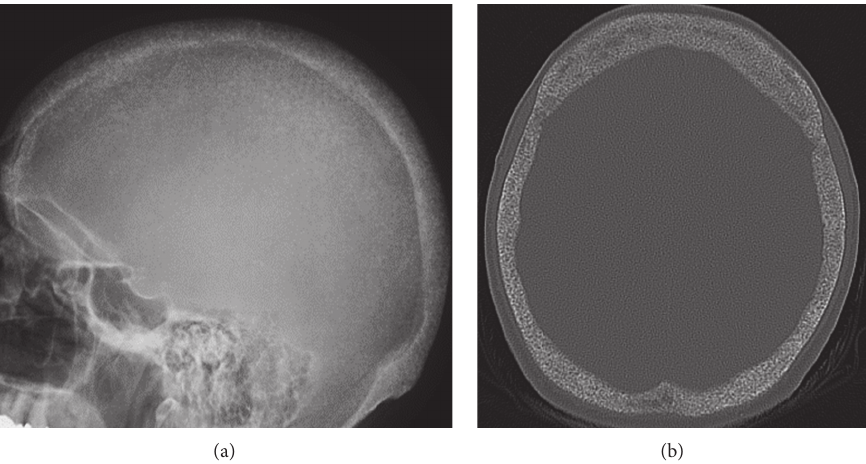
Figure 8: “Salt-and-pepper-skull.” Lateral skull X-ray and axial bone windows CT with salt-and-pepper appearance from trabecular bone resorption depicted as fine areas of lucency mixed with sclerotic radiopaque-denser-dot-like